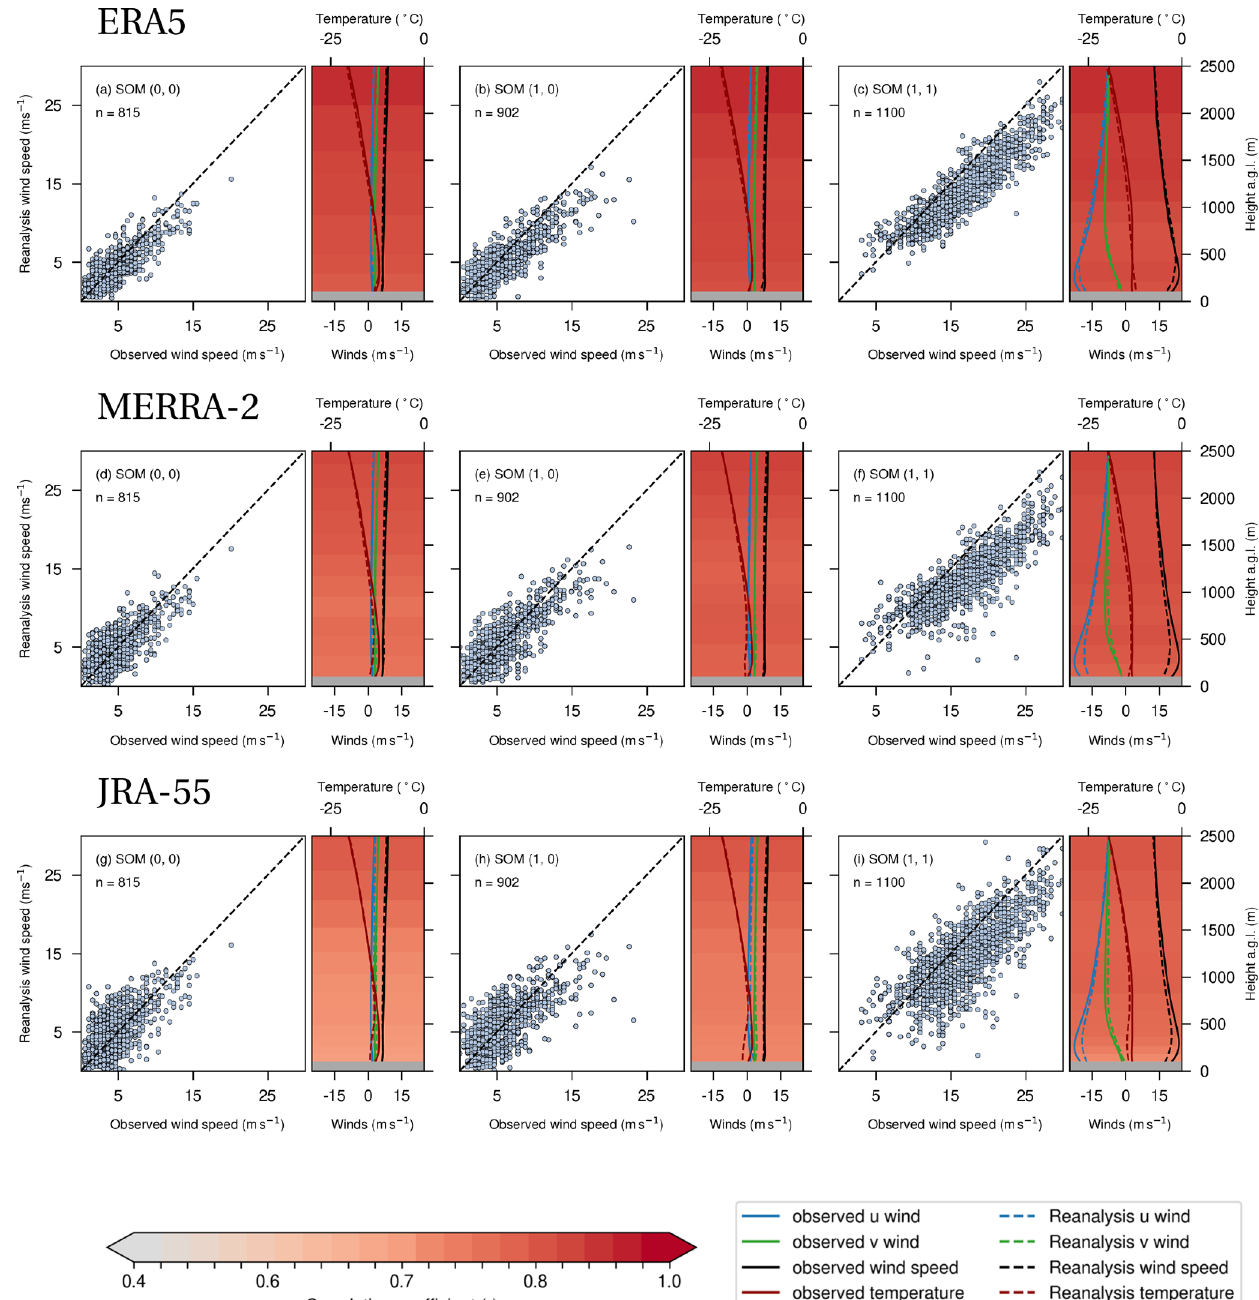
Figure 10. As in Fig. 7 but for Neumayer. All shaded correlation coefficients are significant at the 99% level, according to a two-sided t test. These three SOM nodes account for 61.3% of the total variability at